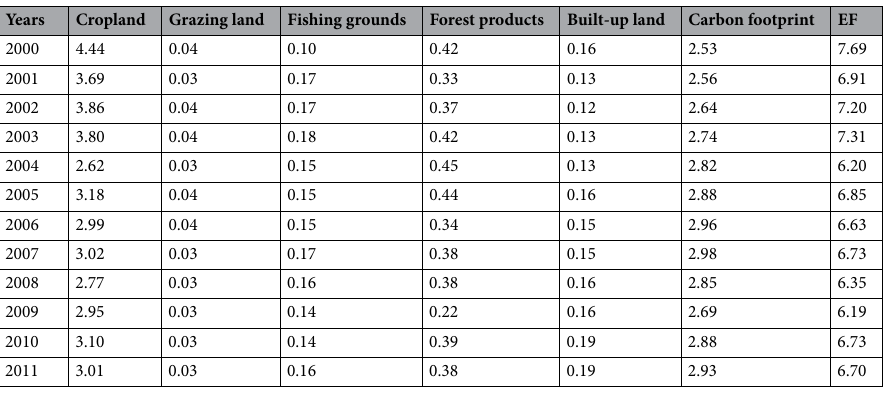
Table 2. Taiwan’s EF from 2001 to 2011 (unit: